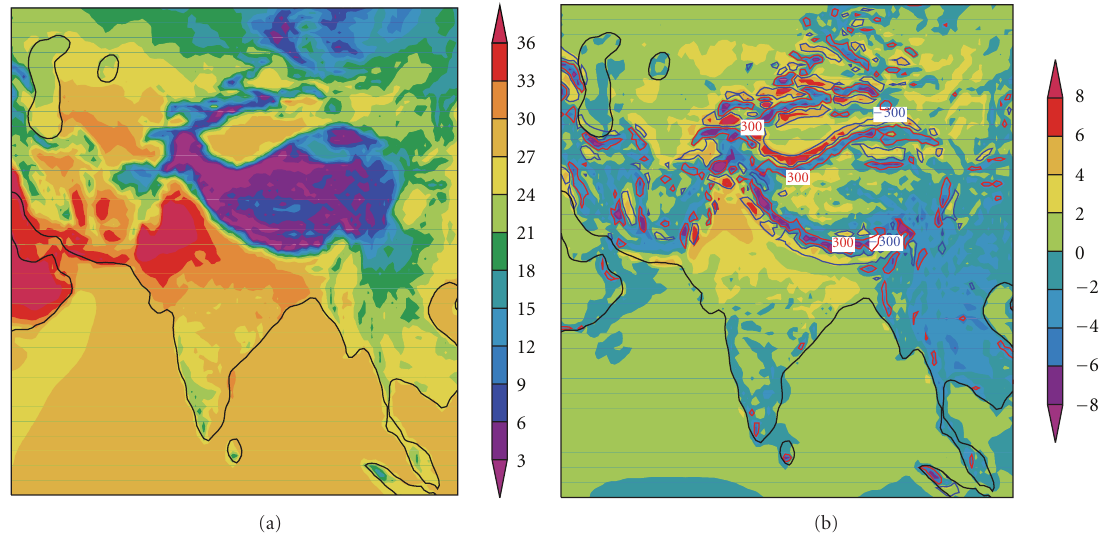
Figure 6: 2m air temperature ( ◦ C; shaded) for HIRHAM (a) and the di ff erence “HIRHAM-ERA40” (b); summer monsoon (JJAS) 1958– 2001. Additionally, the elevation di ff erences “HIRHAM-ERA40” (m; contour lines) are shown in the right panel.